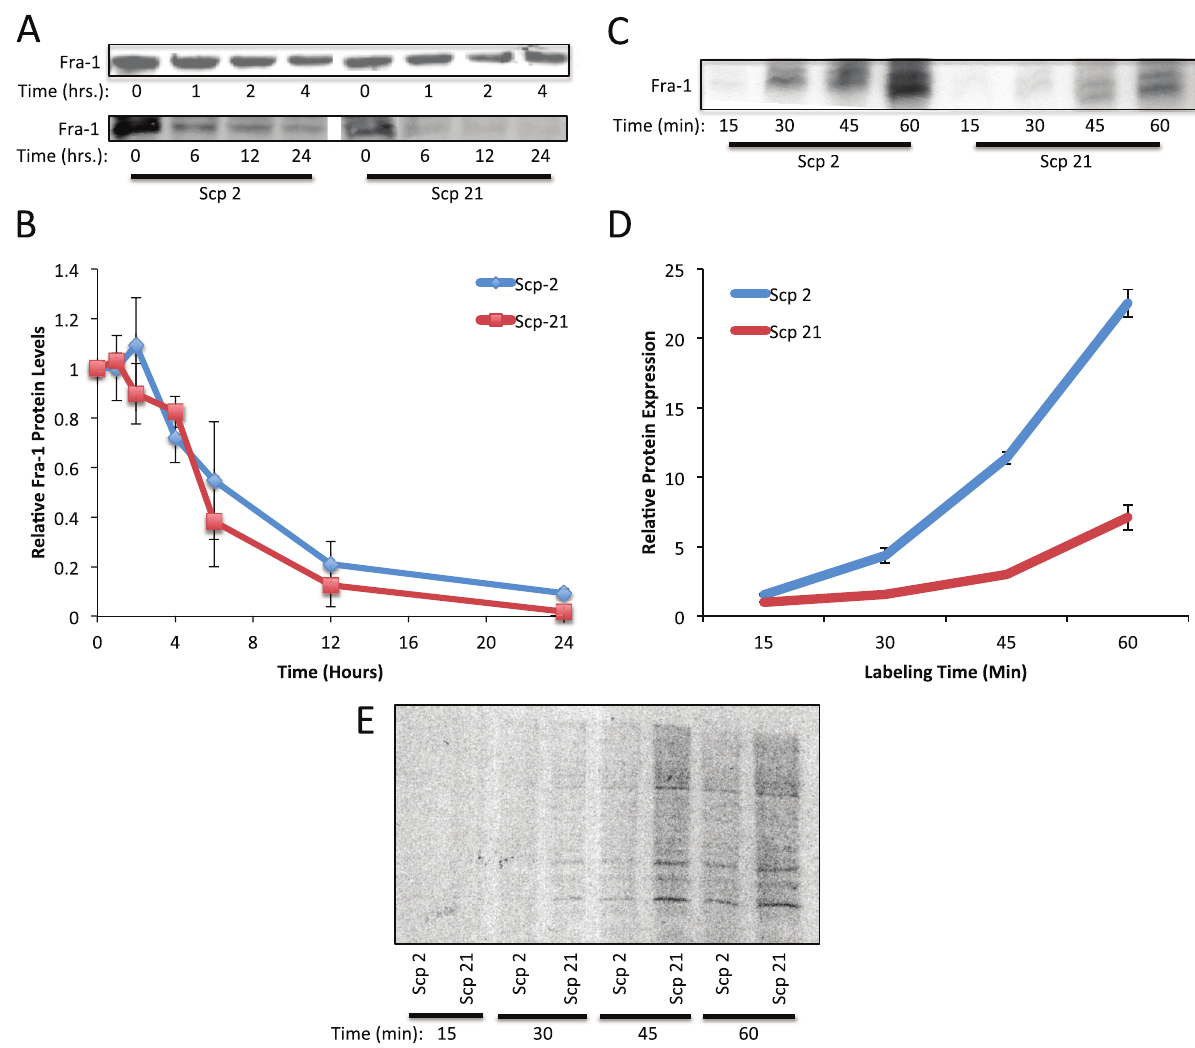
Figure 7. Regulation of Fra-1 protein translation. A ) Fra-1 protein stability. Scp-2 and Scp-21 cells were treated with cycloheximide and whole cell lysates collected at the indicated times post-treatment. Immunoblots are shown with anti-Fra-1 antibody of representative experiments. B ) The mean relative Fra-1 band intensities from immunoblots as in ( A ) from three independent experiments +/- the standard deviation are shown. C ) 35 S-metabolic labeling of Fra-1. Cells were depleted of cysteine and methionine for 30 minutes and labeled